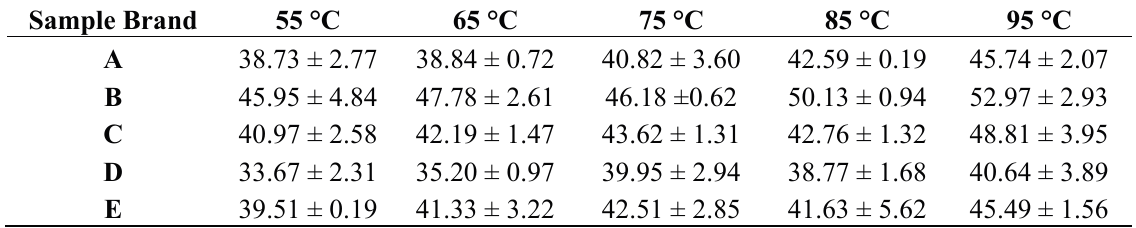
Table 4. Solubility analysis of the herbal pharmaceutical products at different temperatures. Sample